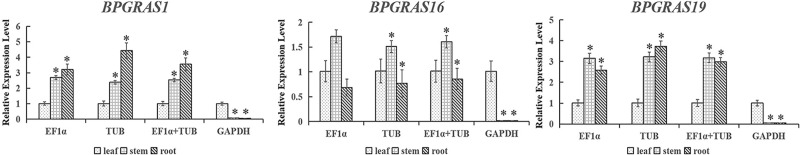
Expression levels in birch using the validated reference genes.Samples of leaves, stems, and roots in normal conditions assessed using qRT-PCR with different internal reference gene to normalize the expression of BpGRAS genes. * represented 0.01 < P < 0.05.